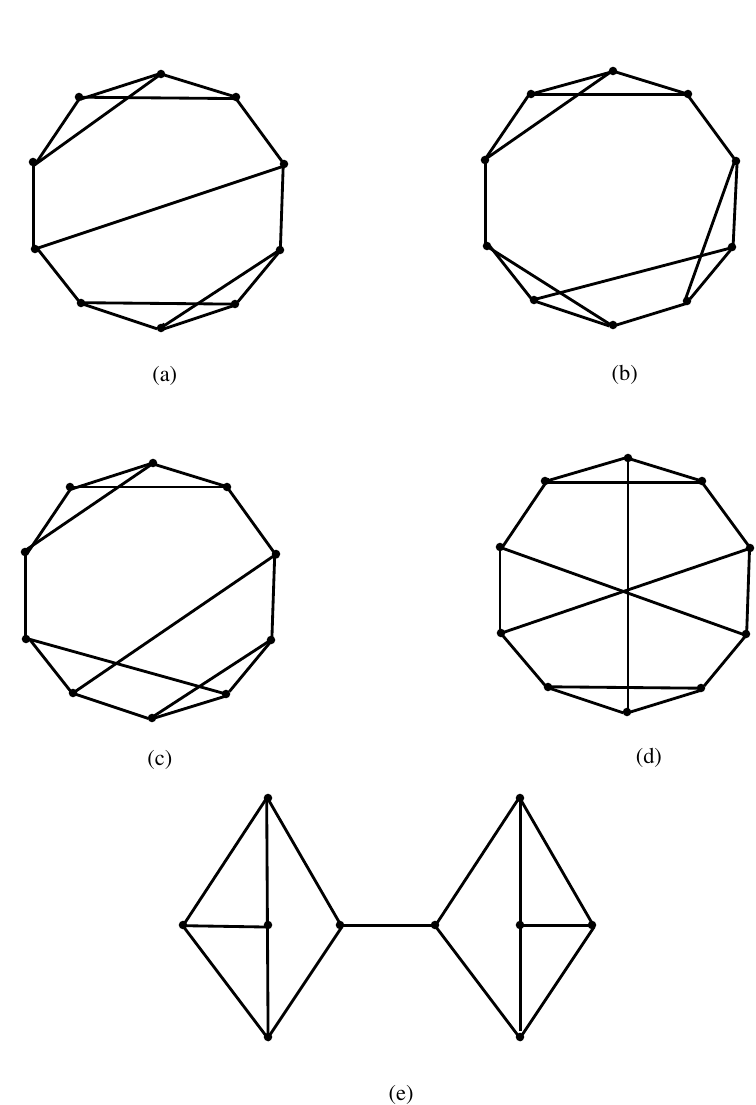
Fig. 8: Cubic graphs on 10 vertices with detection number